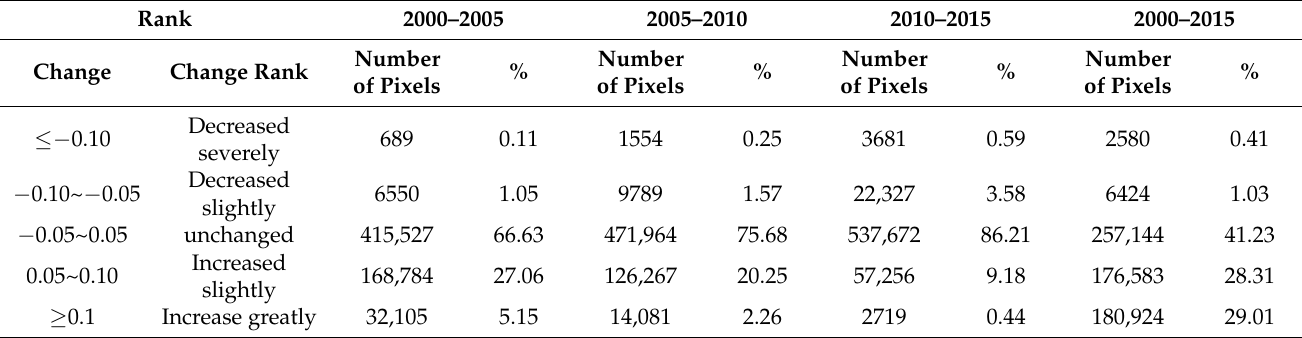
Table 7. Changes in the NDVI in different periods of ecological engineering on the Loess